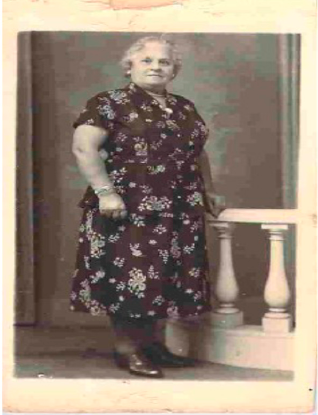
Figure 8. Olga’s portrait to her sister (author’s collection).